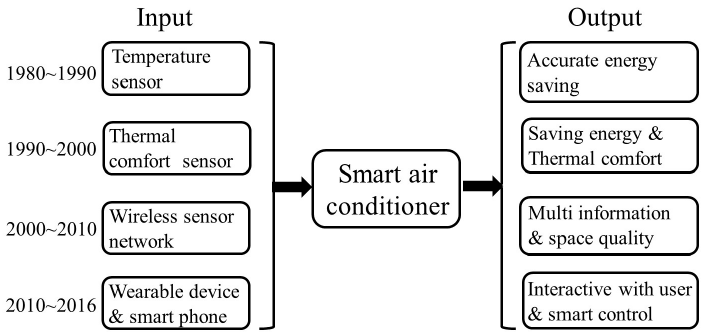
Figure 2. The qualitative analysis of the developed sensor technologies and achieved smart controls of the selected case studies in Table 2.